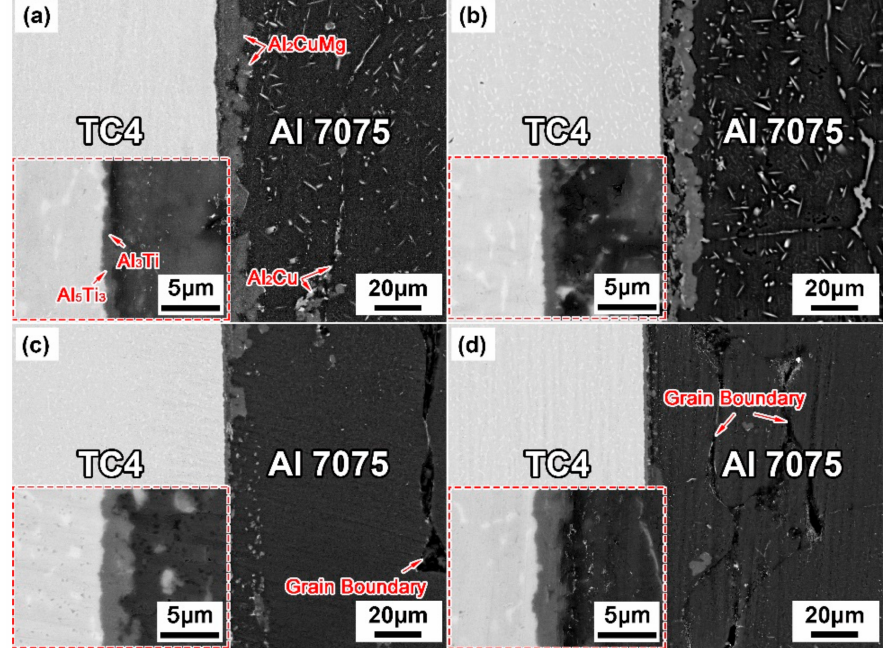
Figure 5. Interfacial microstructures of brazed joints at 600 ◦ C for different holding times. ( a ) 15